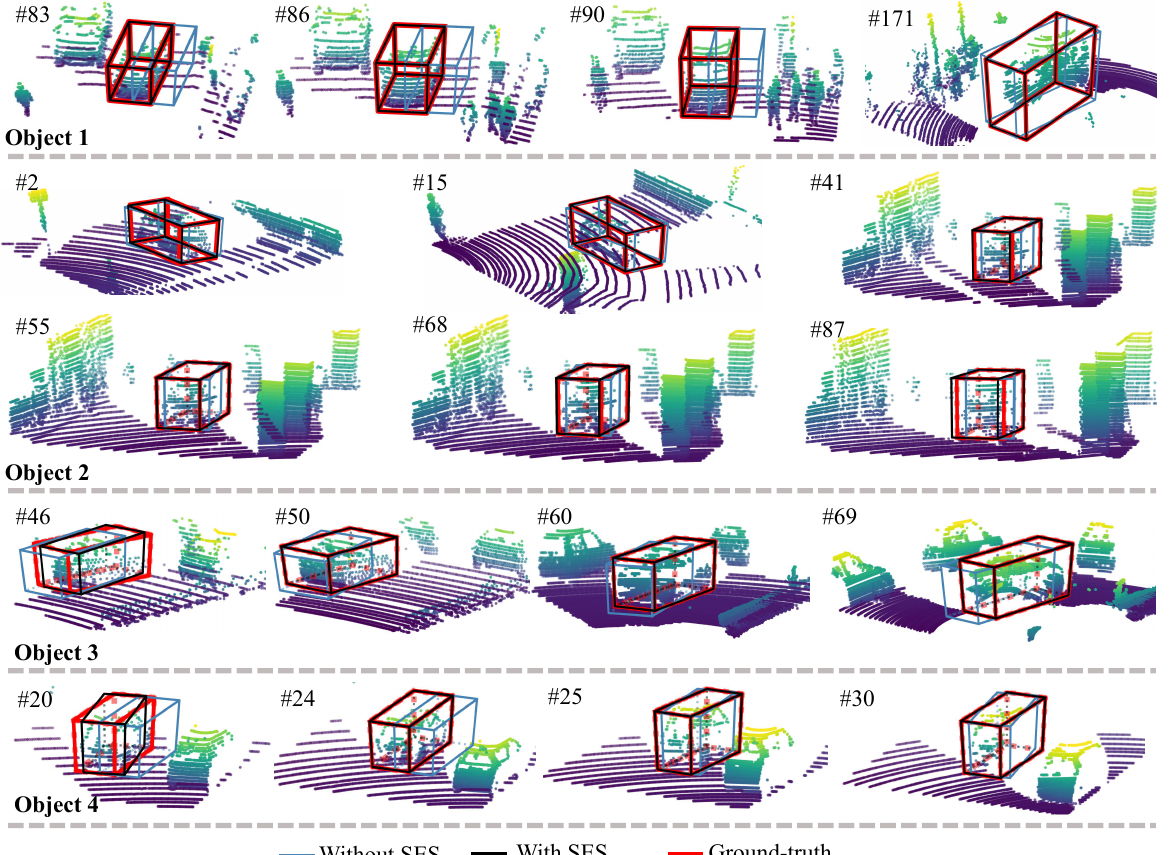
Figure 8. Tracking results with or without the state estimation subnetwork (SES). The black bounding boxes were obtained with SES, and the blue bounding boxes without SES. As we can see, with the help of SES, a rough state (blue boxes) can be favorably meliorated. The number after # is the frame ID.